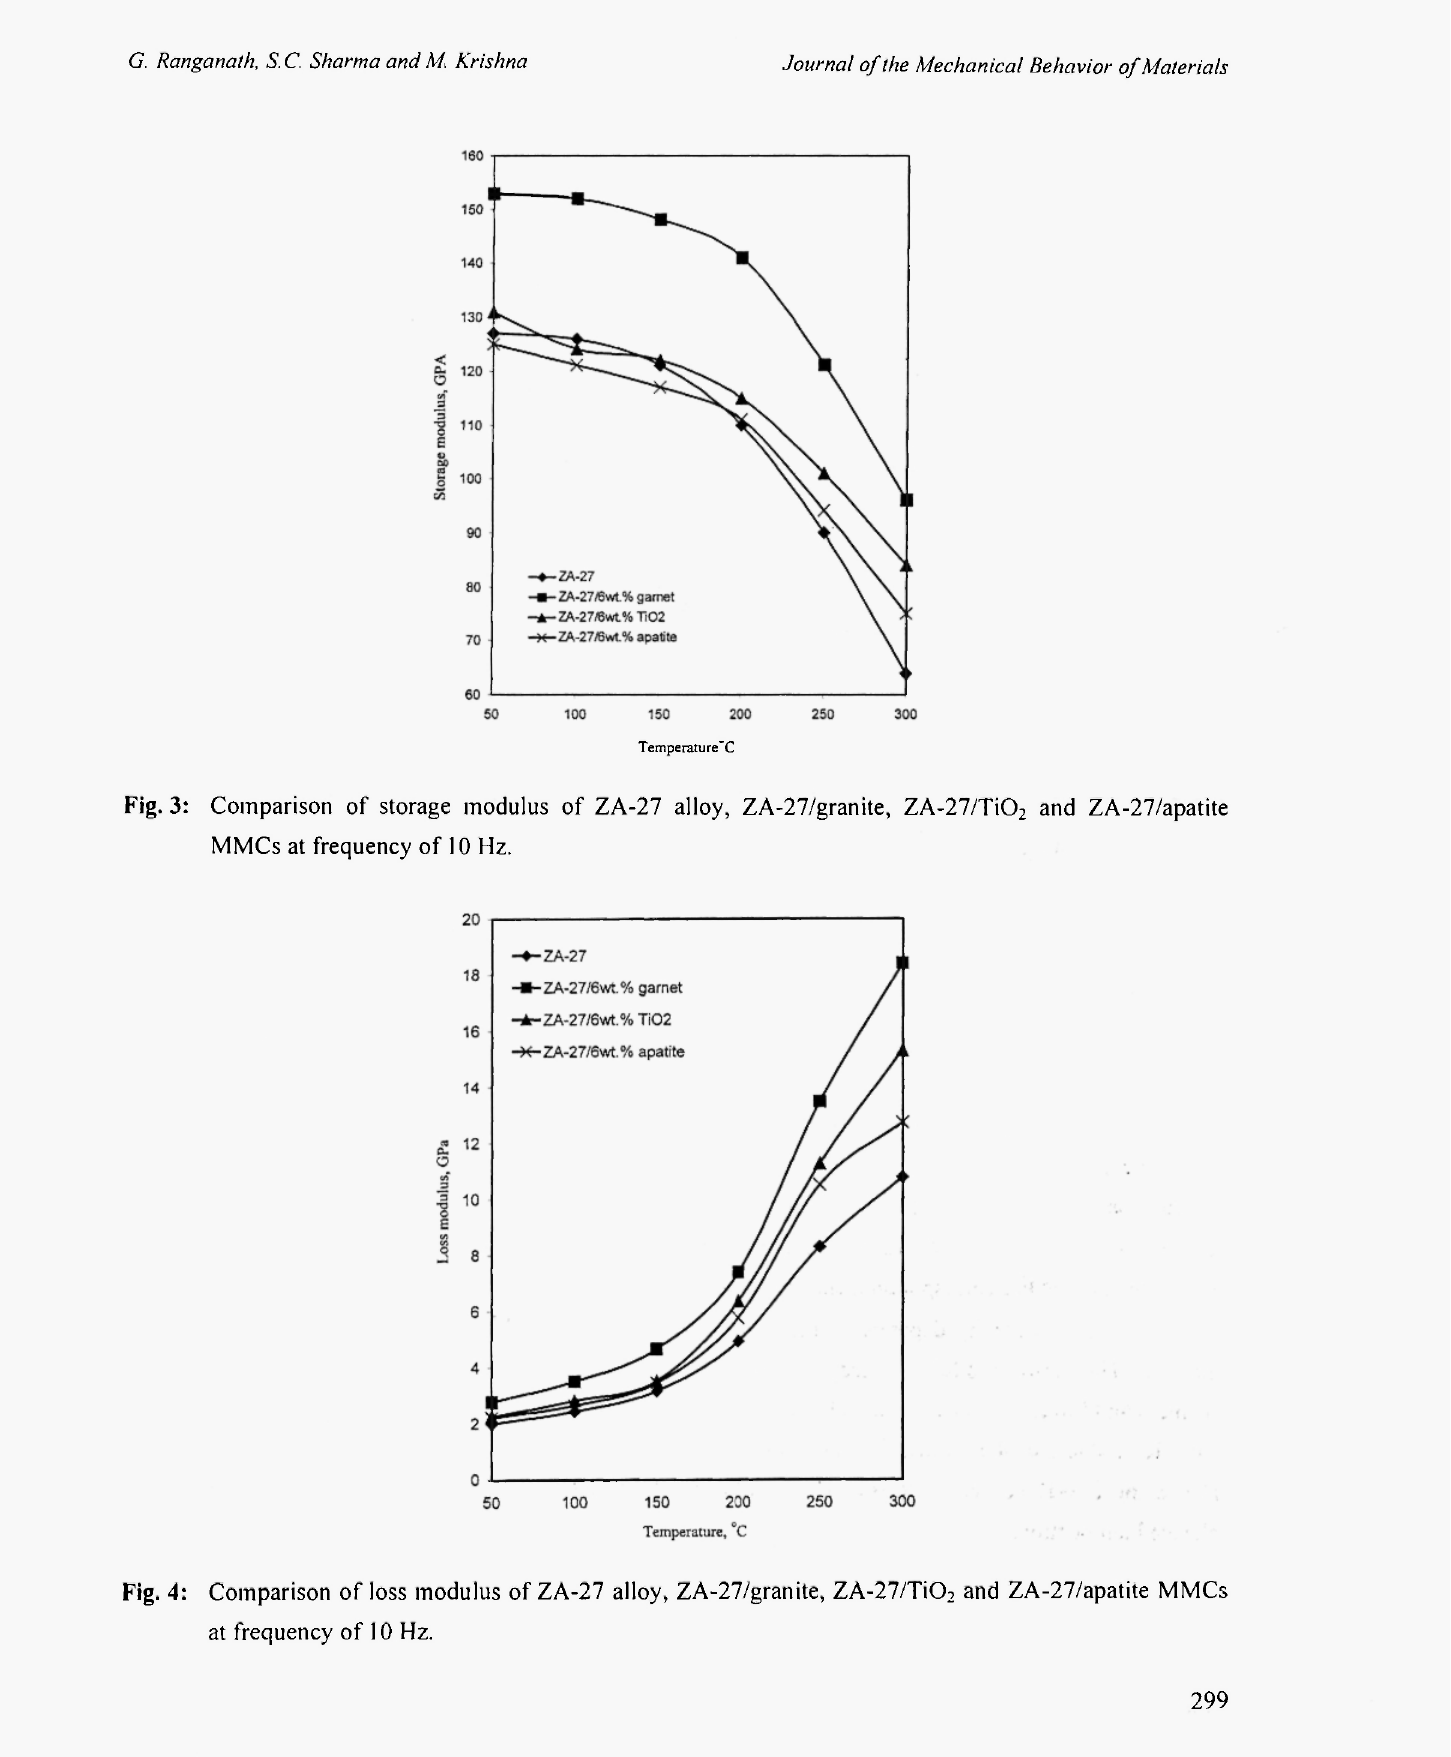
Fig. 4: Comparison of loss modulus of ZA-27 alloy, ZA-27/granite, ZA-27/Ti0 2 and ZA-27/apatite MMCs at frequency of 10